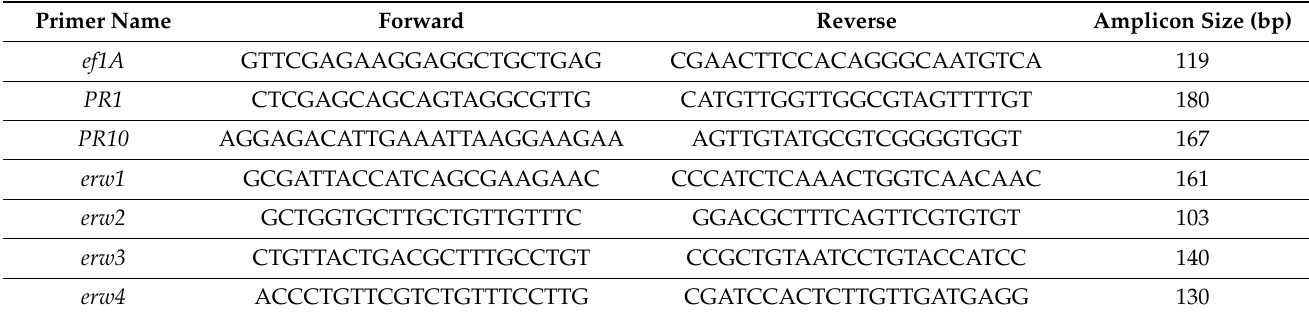
Table 1. The sequences of primers of PRs pear genes and erw genes, used in the qRT-PCR